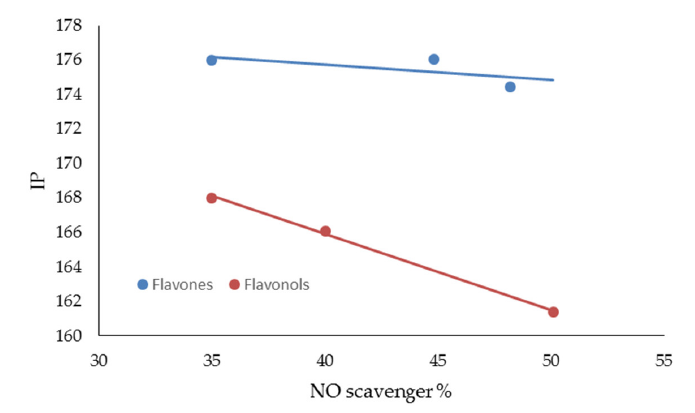
Figure 7. Relationships between the NO scavenger % and ionization potential (IP) values for flavones and